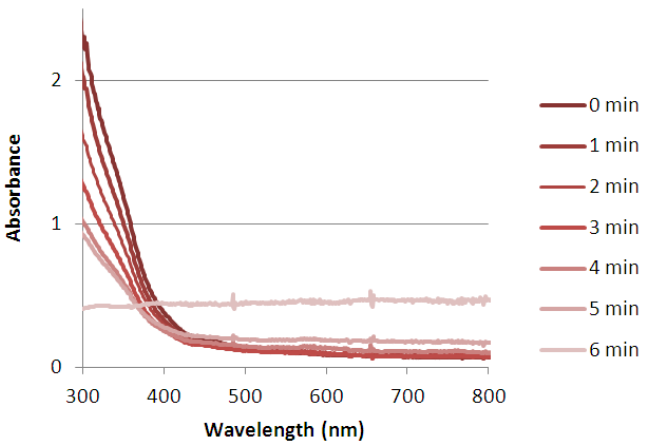
Figure 3. Change in UV-Vis absorption spectra of iron(III) cross-linked hydrogel contacting 20 mM aqueous solution of lactic acid upon irradiation with 405 nm